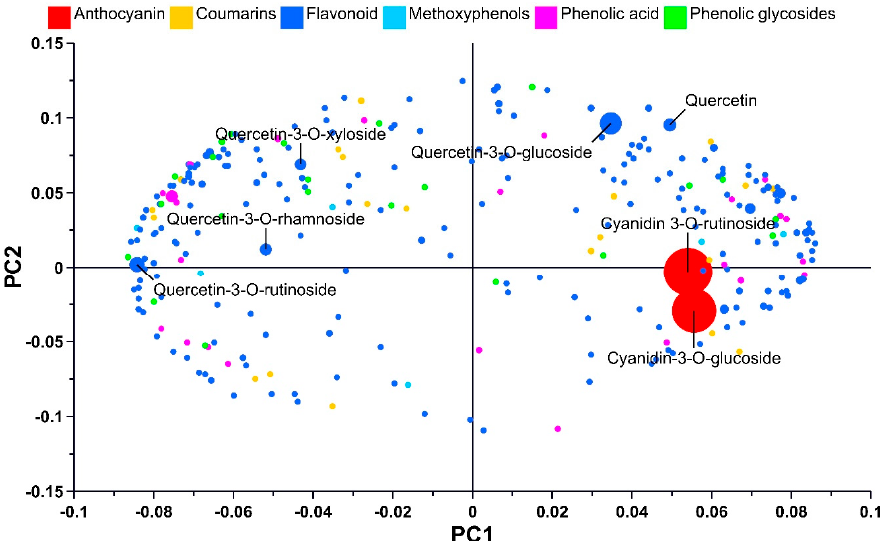
Figure 3. PCA loadings plot from QGP extracts. Metabolites are coloured by their class and scaled for size by the relative abundance of a QC sample. Metabolites in high abundance appear as larger dots than metabolites in low abundance. Cyanidin-3- O -glucoside and Cyanidin-3- O -rutinoside are very high in abundance compared to the other polyphenols. Flavonoids are the most common polyphenol present in QGP ethanolic and glycerol extracts. Phenolic acids, phenolic glycosides, methoxy phenols, and coumarins are less abundant than flavonoid derivatives.